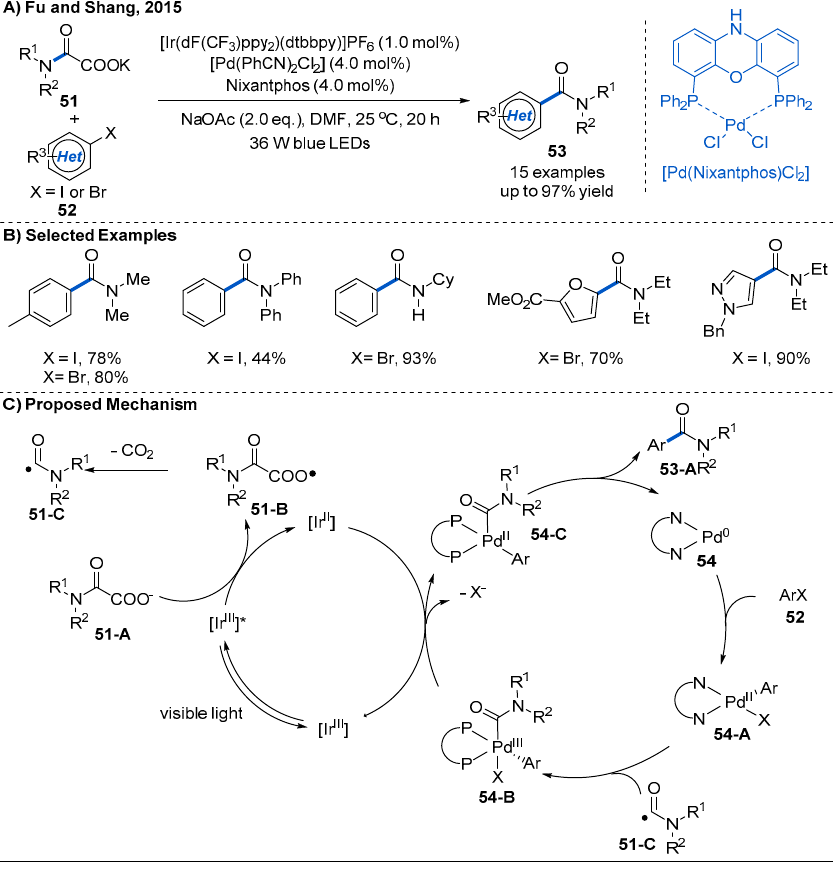
Figure 18. Visible-light-mediated dual photoredox and palladium-catalyzed decarboxylative cou- plings between α -oxocarboxylates and aryl halides.